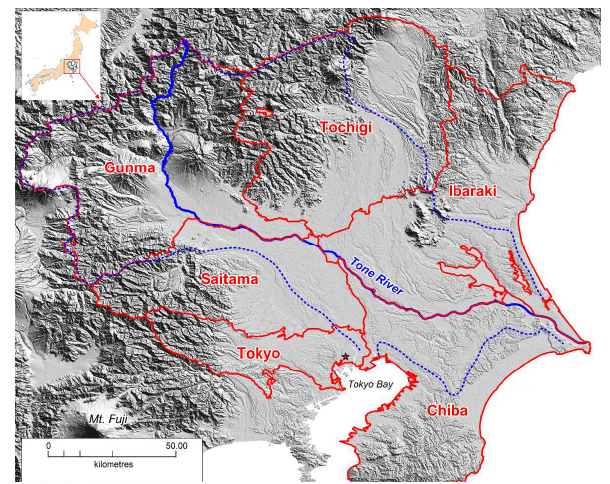
Fig 1: Tone River and its catchment boundary with surrounding prefectures . Tone River is indicated by the bold blue line. The catchment boundary of Tone River is depicted by the dotted blue line. The red star within the Tokyo Metropolitan Area represents central Tokyo.